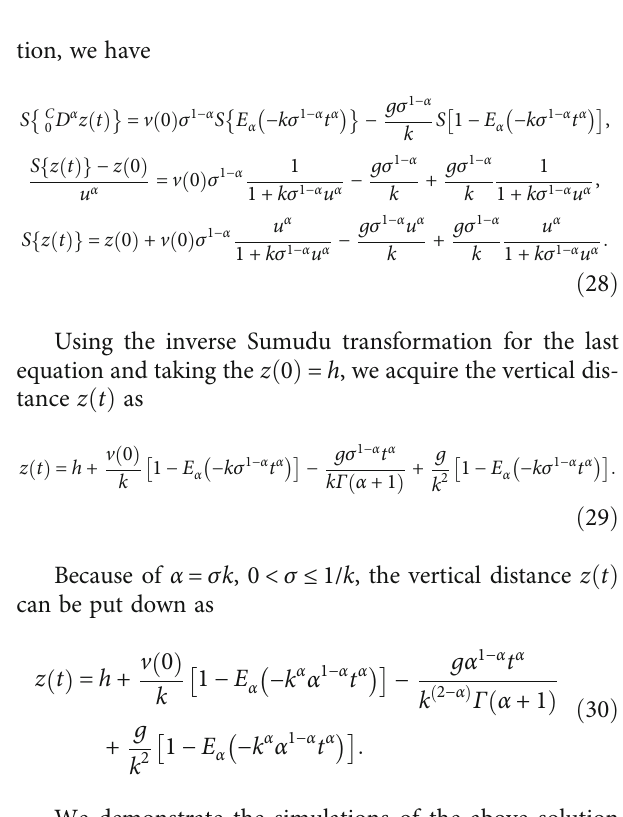
Figure 3: Simulations of the solution for α = 0 : 98 and α = 0 : 99